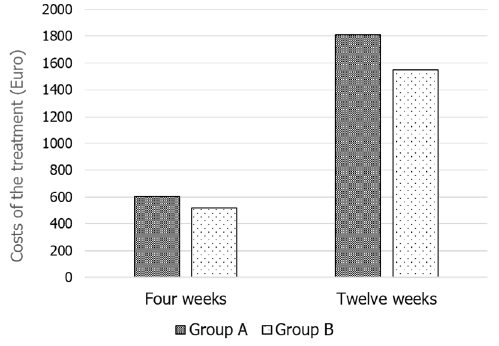
Figure 3. Cost analysis of the two FSH therapeutic schemes for 4 or 12 weeks of